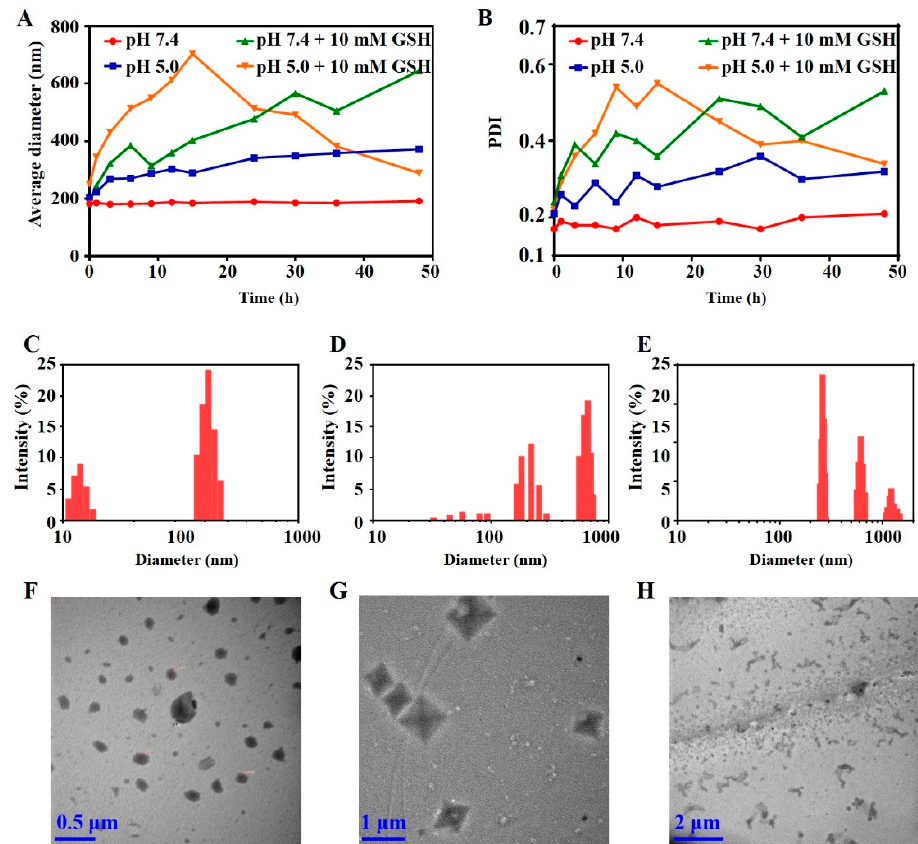
Figure 3. Stability evaluation of oDex-g-Pt+DOX NPs (platinum plus DOX conjugated oxidized dextran nanoparticles) monitored by DLS and TEM. ( A ) Average particle size of oDex-g-Pt+DOX NPs after incubation under different conditions. ( B ) Size distributions of oDex-g-Pt+DOX NPs after incubation under different conditions. Size and size distribution of oDex-g-Pt+DOX NPs incubated in pH 5.0 ( C ), pH = 7.4 with 10 mM GSH ( D ), and pH = 5.0 with 10 mM GSH ( E ) for 24 h. TEM images of oDex-g-Pt+DOX NPs incubated in pH 5.0 ( F ), pH = 7.4 with 10 mM GSH ( G ), and pH = 5.0 with 10 mM GSH ( H ) for 24 h.